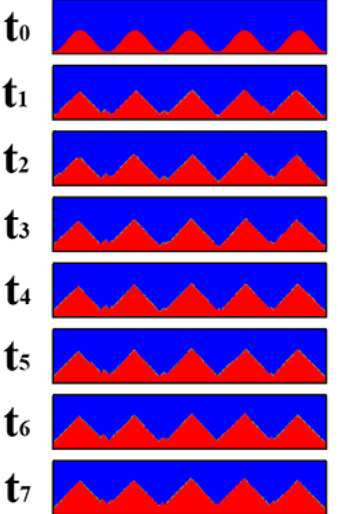
Figure 8. Isochorones of interface at every 200 time steps.